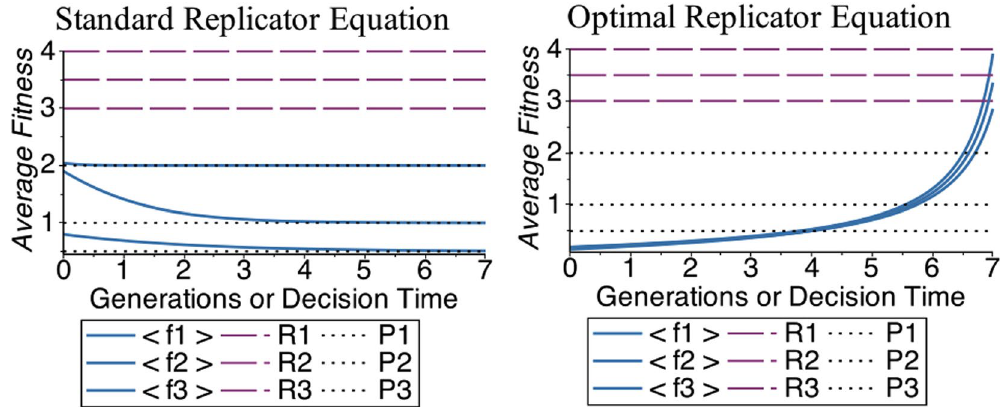
Figure 2. Evolution of the average fitness of the population in the PD. On the left panel we present the evolution according to the standard Replicator Equation, while the right panel is the evolution of the same system according to the Optimal Replicator Equation introduced here. The payoffs and the initial conditions used in these examples are reported in Table 1. While using the standard RE the average fitness of the population decreases and approaches the payoff for mutual defection ( P ), in the system governed by the ORE the average fitness increases and approaches the payoff for mutual cooperation ( R